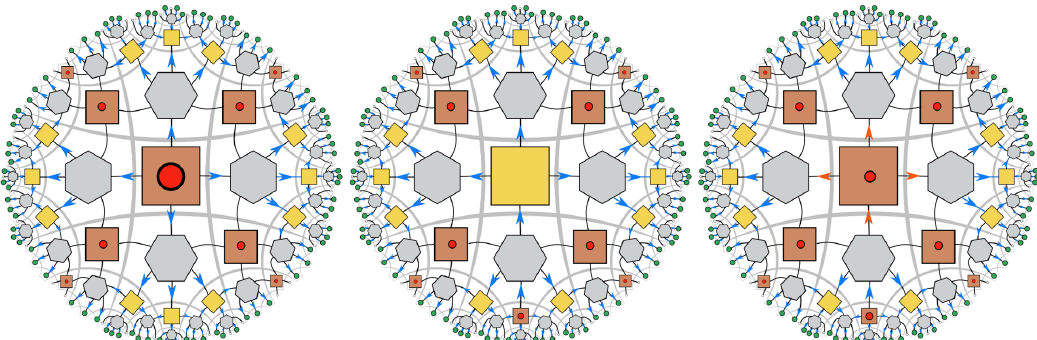
Figure 38. We can identify different bulk subspaces that are recoverable from the boundary. Each individual subspace (left, center) is exactly recoverable, however their union (right) is